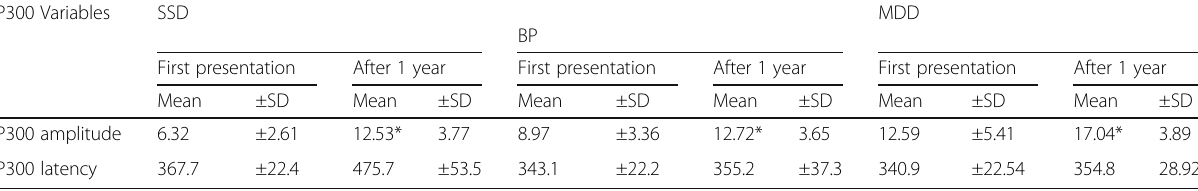
Table 4 Comparison of the P300 variables, at first presentation and after 1 year among first-episode psychosis diagnostic groups